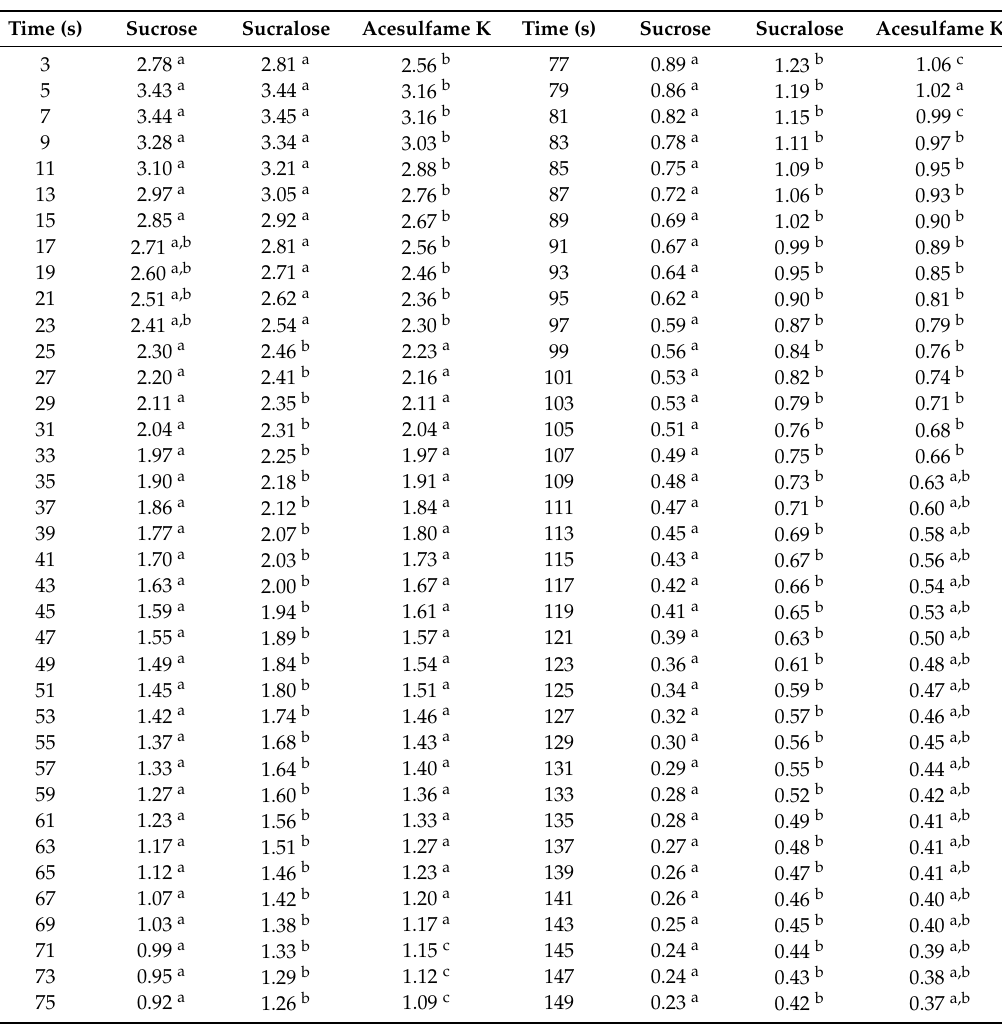
Figure 3. Temporal profiles of sweetness of each sweetener in water solution. Temporal profiles of sweetness were obtained for 150 s after participants swallowed sweetened water solutions. Table 1. Results of sweetener in water solution: multiple comparisons for the significant simple main effects of sweetener in 74 time